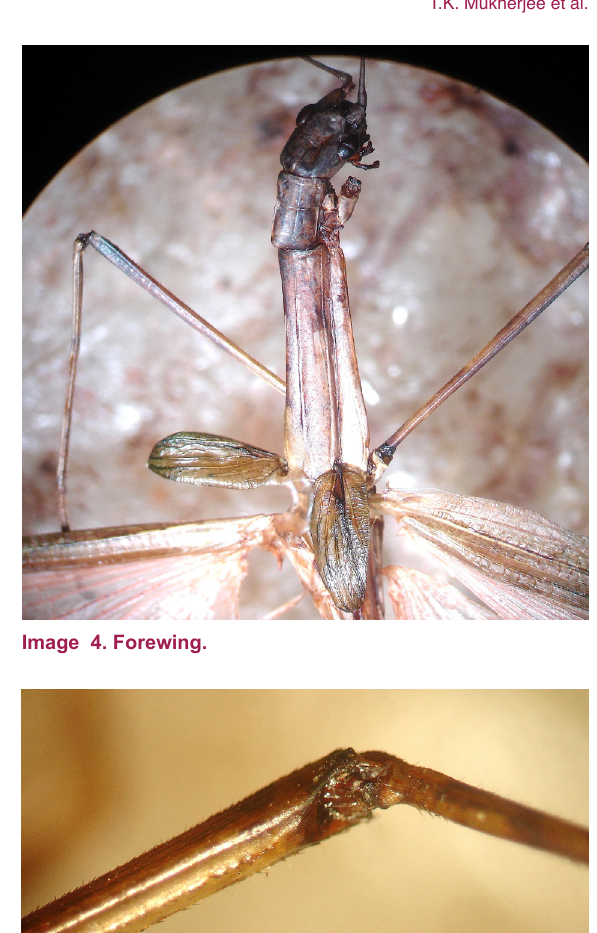
Image 5. Hind femur-tibial junction. and scattered blackish patches and also an elongated narrow white patch on each side, (ii) in forewing, radial vein strong and black and without black-spots in middle, (iii) in hindwing, costal and radial areas as a whole are more brownish than the posterior area which is uniformly but less brownish, not white; all long veins with black marks at